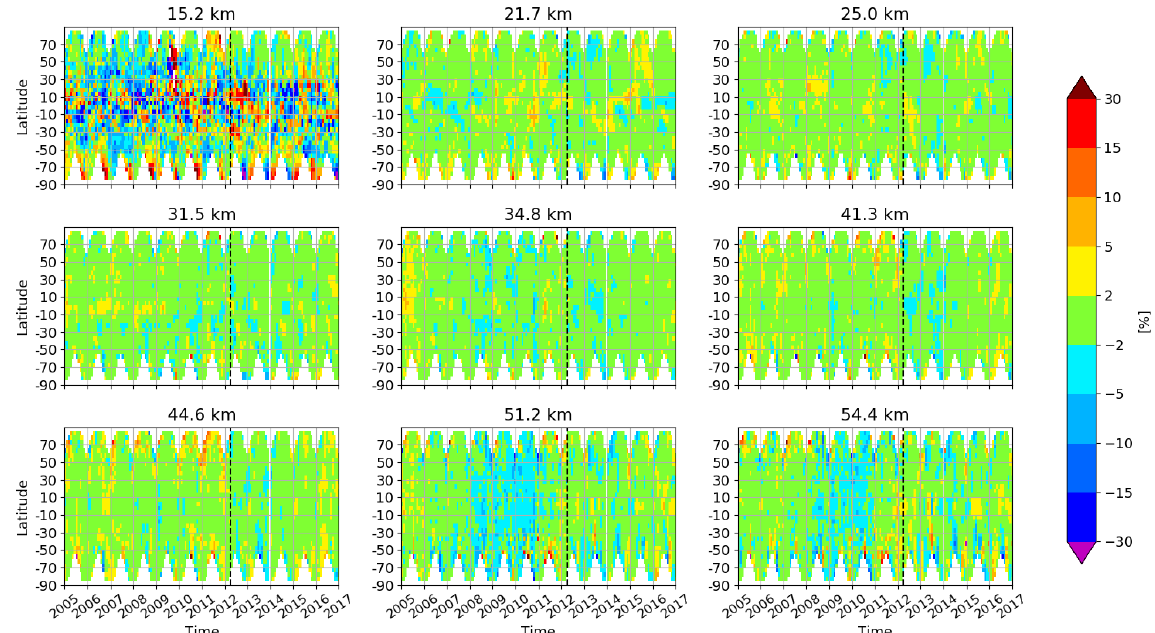
Figure 4. Differences of the merged relative anomaly time series with respect to MLS anomalies as a function of latitude at selected altitudes, computed according to Eq. (6). The vertical dashed lines indicate the transition between SCIAMACHY and OMPS-LP data sets. MLS data have been offset to SCIAMACHY before the